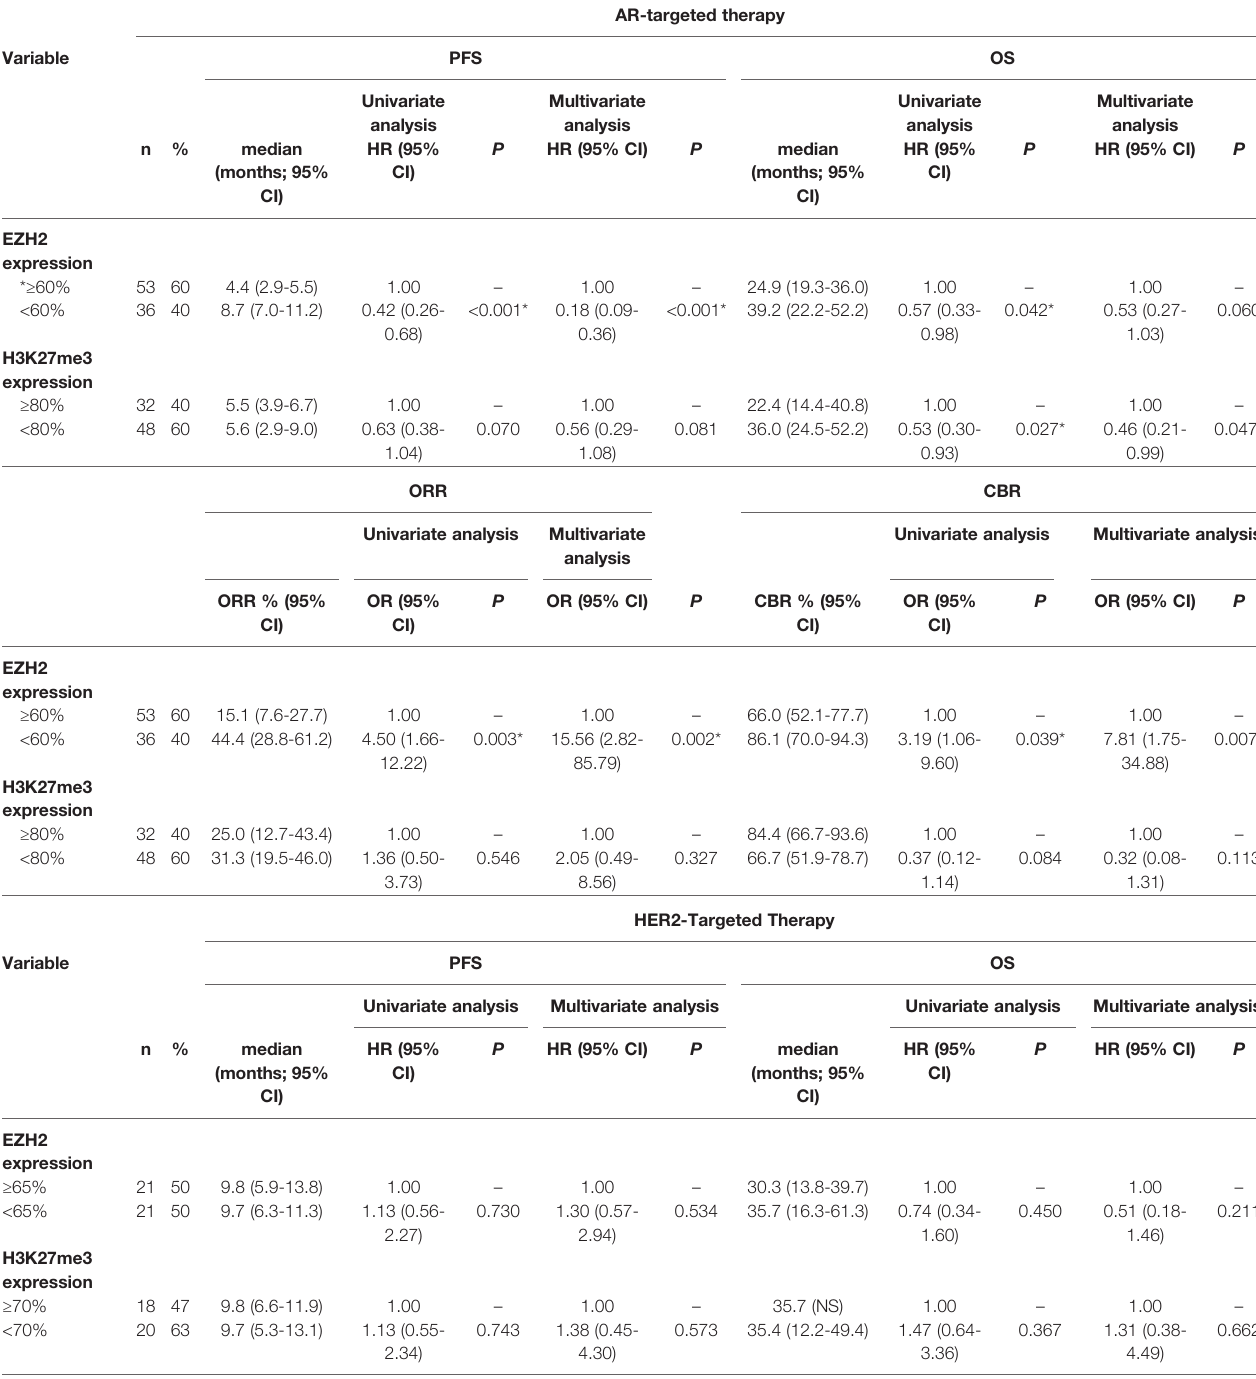
TABLE 4 | The association between EZH2 or H3K27me3 expression and clinical outcomes in patients with salivary duct carcinoma treated with AR- or HER2- targeted